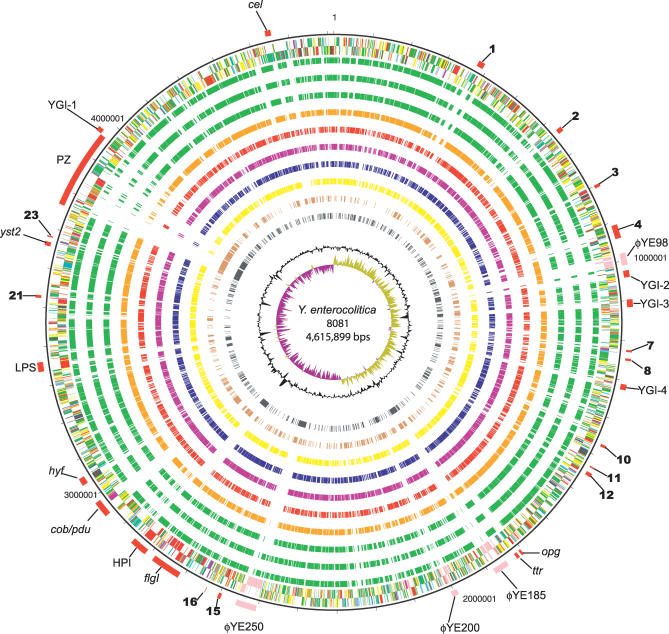
Circular Representation of the Y. enterocolitica Strain 8081 ChromosomeThe outer scale shows the size in bps. From the outside in, circles 1 and 2 show the position of CDSs transcribed in a clockwise and anticlockwise direction, respectively (for colour codes see below). Circles 3–5 (all CDSs coloured green) mark the position of Y. enterocolitica strain 8081 genes that have orthologues (by reciprocal FASTA analysis) in Y. pestis strains CO92, 91001, and KIM10+ and in (circle 6) Y. pseudotuberculosis strain IP32953 (CDSs coloured orange), respectively. Circles 7–10 show the Y. enterocolitica strain 8081 CDSs present (as detected by microarray) in all of the Y. enterocolitica isolates tested from biotype 1A (eight strains, red), biotype 2 (two strains, pink), biotype 3 (eight strains, blue), and biotype 4 (eight strains, yellow). Circle 11 shows CDSs unique to Y. enterocolitica strain 8081 (brown) compared with Y. pestis strain CO92 and Y. pseudotuberculosis strain IP32953 as determined by reciprocal FASTA analysis. Circle 12 shows CDSs unique to Y. enterocolitica strain 8081 (black) biotype 1B compared to all isolates of Y. enterocolitica biotypes 1A, 2, 3, and 4 as determined by microarray analysis. Circle 13 shows a plot of G + C content (in a 10-kb window) and circle 14 shows a plot of GC skew ([G − C]/[G + C] in a 10-kb window). Genes in circles 1 and 2 are colour-coded according to the function of their gene products: dark green, membrane or surface structures; yellow, central or intermediary metabolism; cyan, degradation of macromolecules; red, information transfer/cell division; cerise, degradation of small molecules; pale blue, regulators; salmon pink, pathogenicity or adaptation; black, energy metabolism; orange, conserved hypothetical; pale green, unknown; and brown, pseudogenes. The position of prophage elements (pink) and other important regions of difference (mentioned in the text) are marked (red). See Table 2 for a description.LPS, lipopolysaccharide biosynthetic genes.